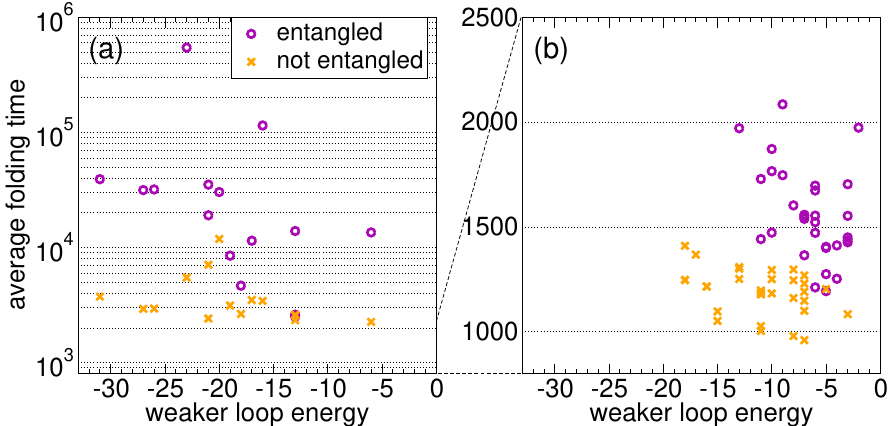
Figure 2. Average folding times into the entangled native state (circles) and into the twin native state without entanglement (crosses), as a function of the weaker of the contact energies involved at the ends of the two loops ( V 1 ). ( a ) 15 independent random sequences; ( b ) fastest proteins after G = 1000 generations of the evolutionary process for 31 independent replicas. Evolution leads to a dramatic drop in time scales (note the log scale for the random sequences), yet the entangled proteins, with respect to their non-entangled twins, still fold more slowly. Note also that the evolved entangled proteins have on average more unstable energetic closures of the